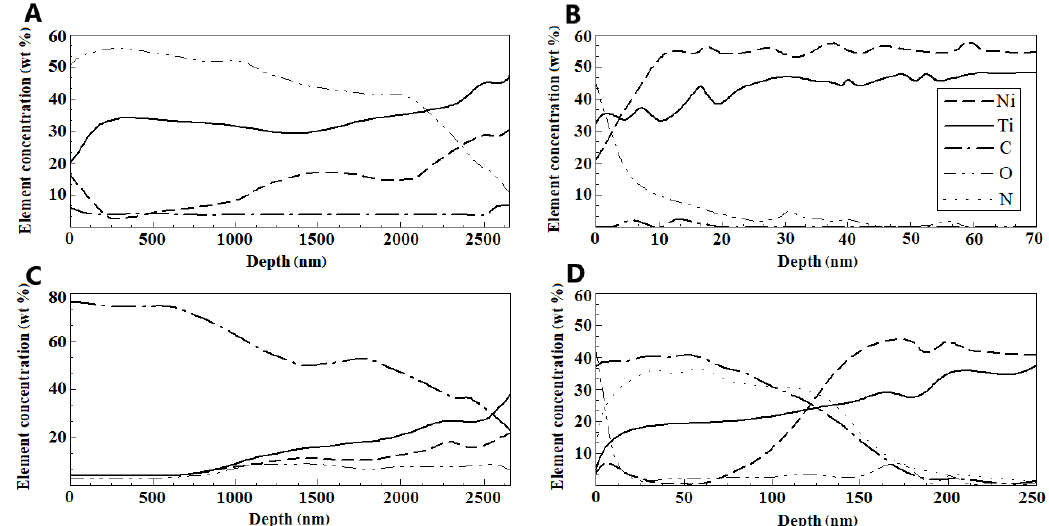
Figure 3. NiTi wire surface composition according to Auger electron spectroscopy before immersion tests: elemental depth profiles of ( A ) bright region (identified in Figure 2A,B) and ( B ) dark region (identified in Figure 2A,B) of the as-received sample and the sample annealed at 450 ◦ C for 15 min; surfaces of samples ( C ) mechanically treated using sandpaper (abrasive grain sizes from 180 to 1000 grit) and diamond paste (3 µ m followed by 1 µ m) and ( D ) mechanically treated and